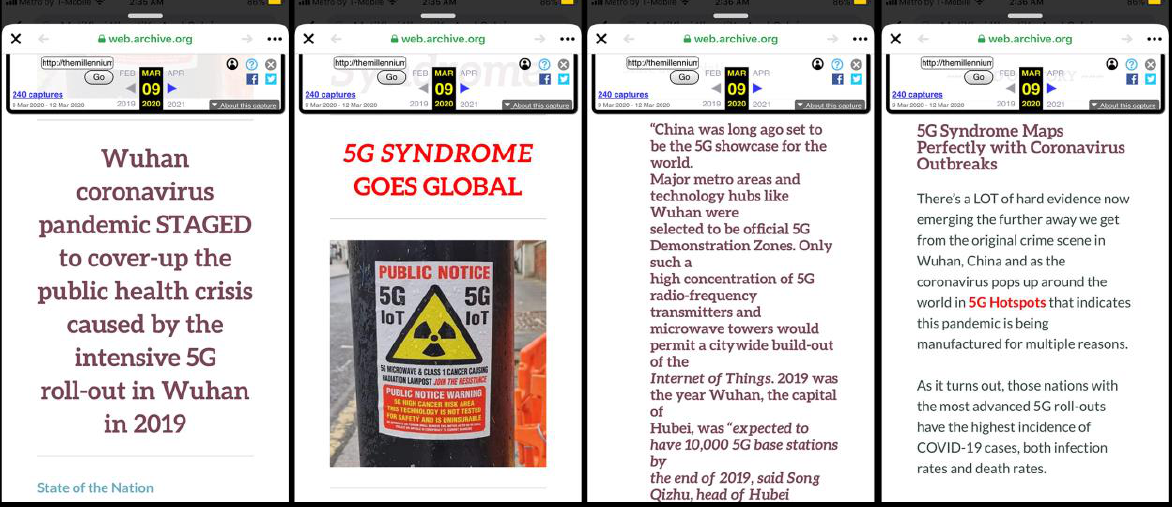
Figure 1. Screensampling: screenshots from web.archive.org taken by @narvonocutz and posted on